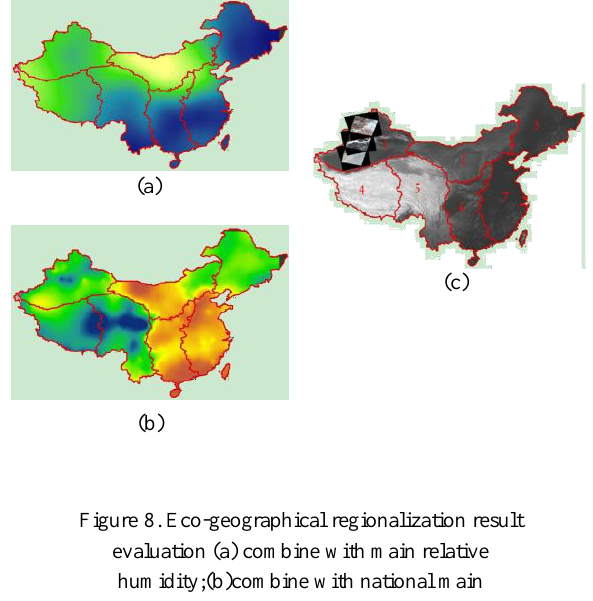
Figure 8. Eco-geographical regionalization result evaluation (a) combine with main relative humidity;(b)combine with national main temperature;(c)combine with DEM